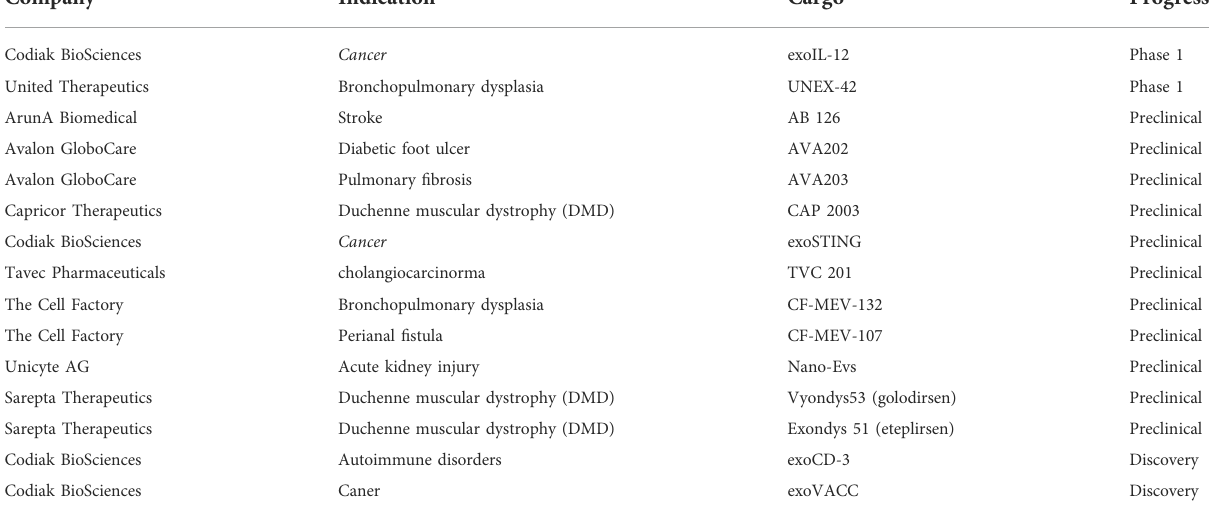
TABLE 2 Exosome drugs and